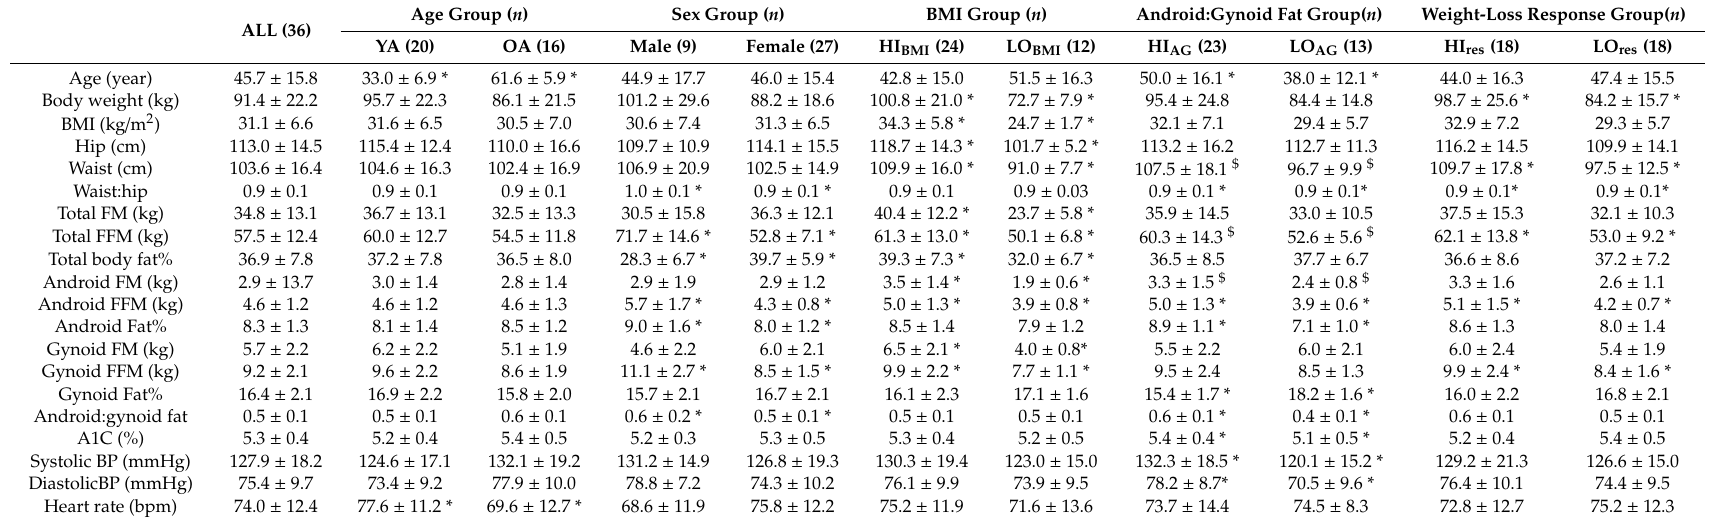
Table 3. Characteristics of study participants post weight-loss including di ff erential features between